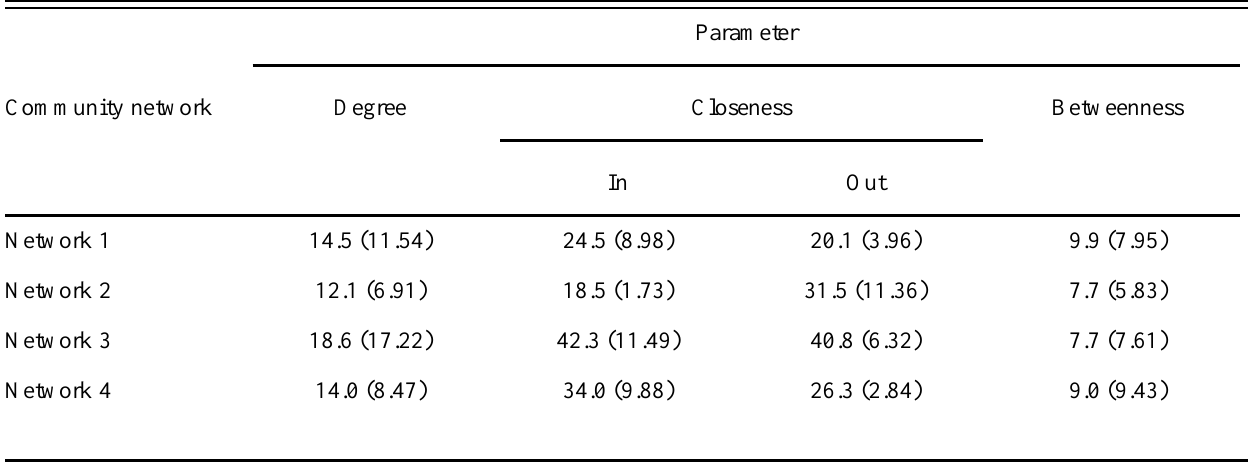
Table 5. Mean (SD) of the degree, closeness, and betweenness parameters averaged over all farmers in each of four community